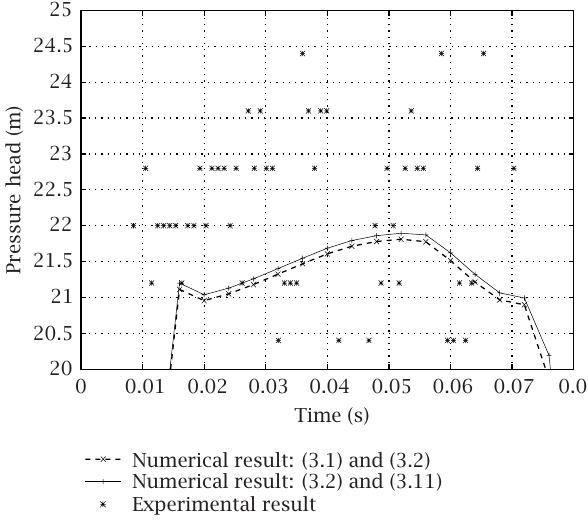
= 0 . 122m/s, 0 ≤ t ≤ 0 . 08. 0